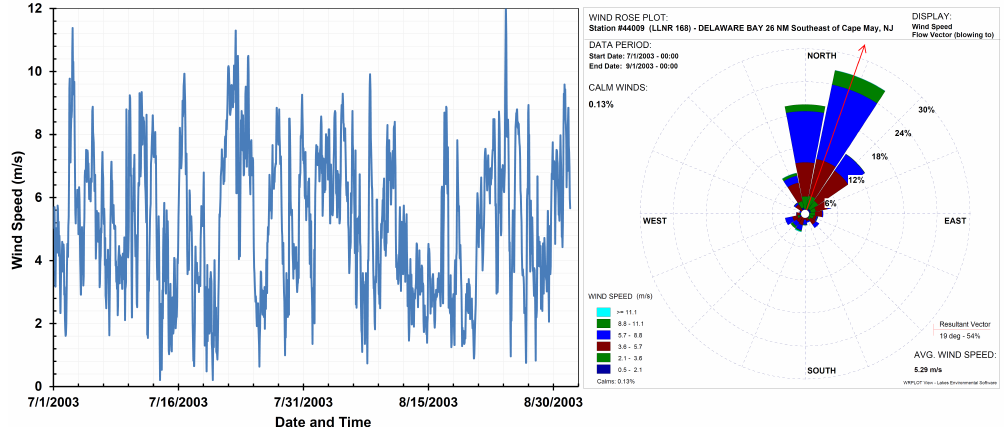
Figure 6. Wind time series and rose plot of the study